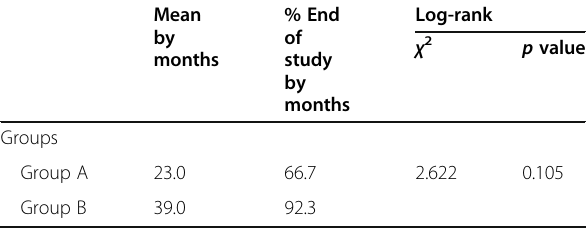
Table 4 Kaplan – Meier survival curves for progression-free survival